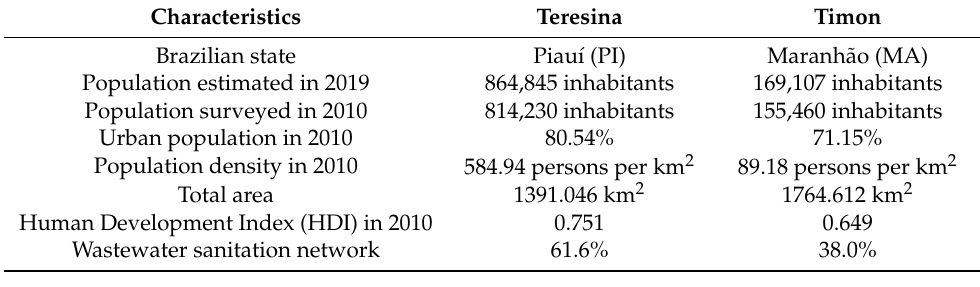
(Table 1: 0.751 in Teresina, and 0.649 in Timon), the percentage of wastewater sanitation network, for example, varies mostly (Table 1: 61.6% in Teresina, and 38.0% in Timon).